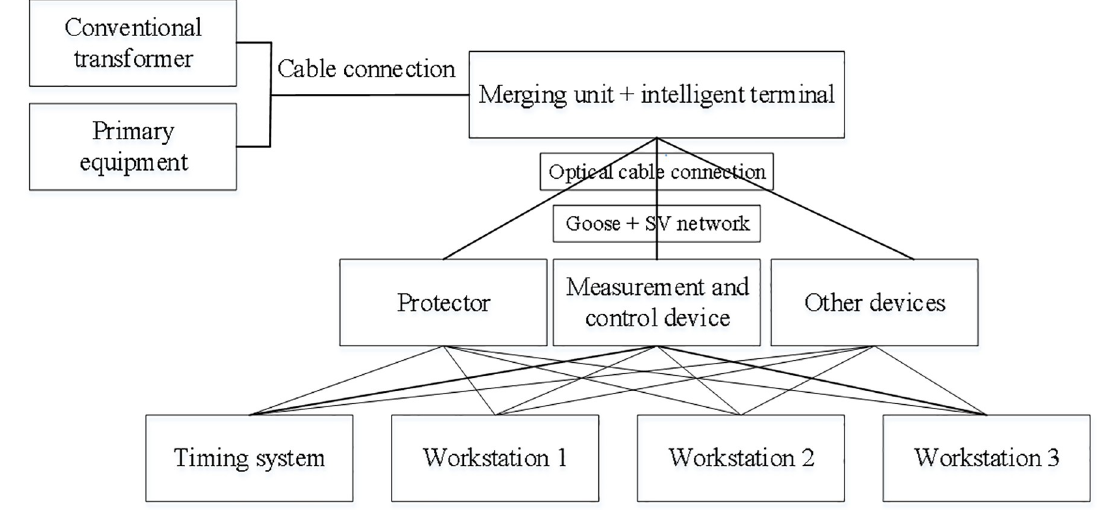
Fig 2. The relay protection system’s composition in an intelligent